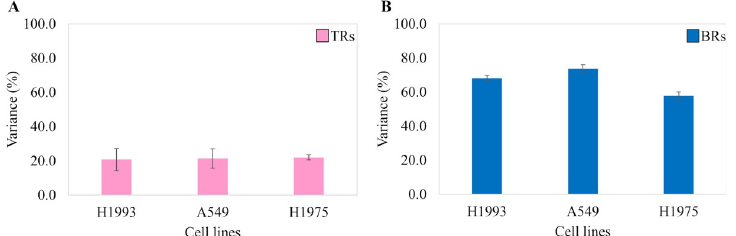
Fig 10. Variance analysis showing quantitative variability in TRs and BRs of three H1993, A549, and H1975 cell line